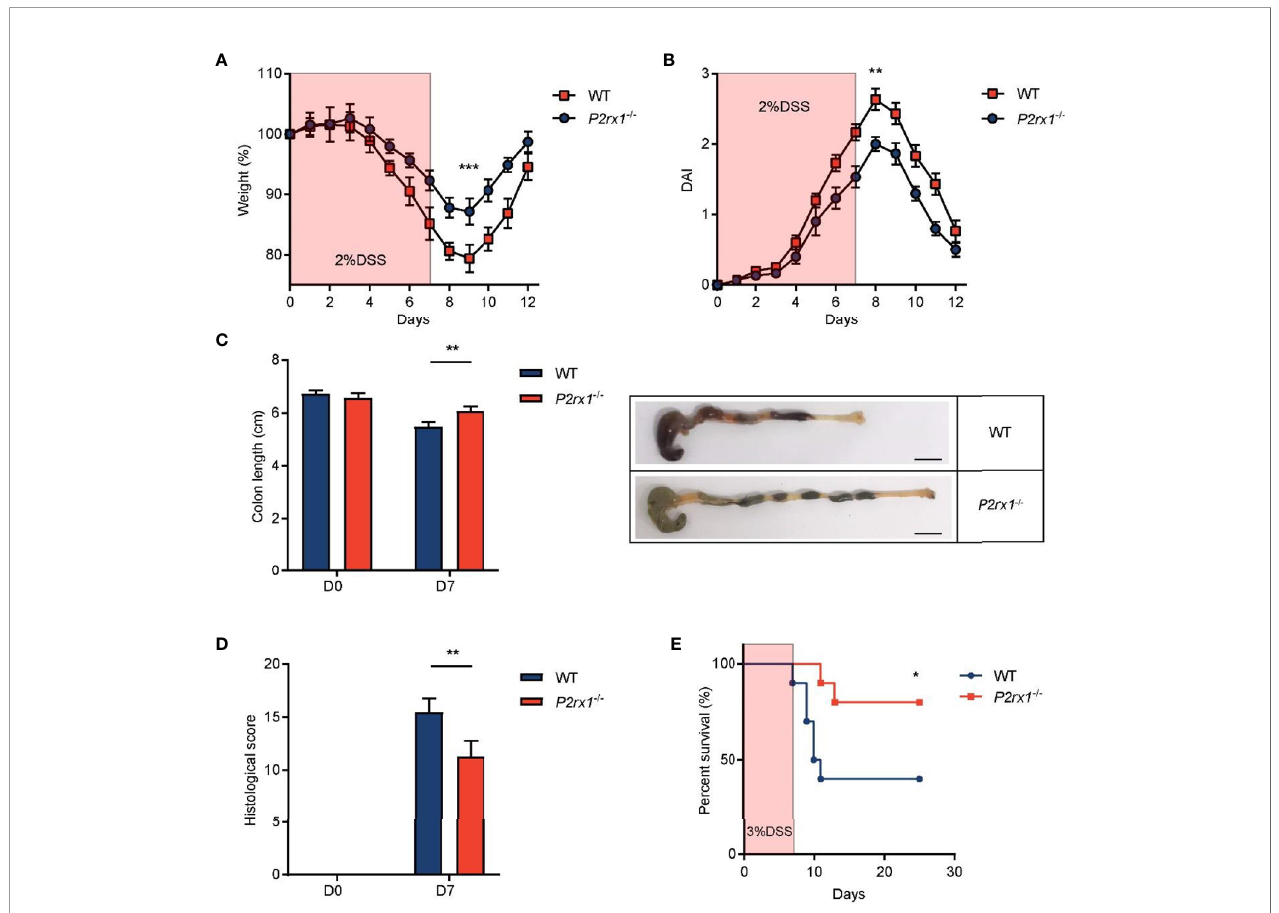
FIGURE 2 | P2RX1 ablation relieves DSS-induced mouse colitis. (A, B) WT and P2rx1 − / − mice were treated with 2% DSS for 7 days. Weight loss (A) and disease activity index (DAI) (B) were calculated (n = 6 per group). (C) Colon length of WT and P2rx1 − / − mice was measured at days 0 and 7. Representative colon tissues at day 7 were shown (n = 6 per group). Scale bar is 1 cm. (D) Histologic score of WT and P2rx1 − / − mice at days 0 and 7 was determined according to pathological examinations (n = 6 per group). (E) WT and P2rx1 − / − mice were exposed to 3% DSS for 7 days, and survival status was monitored for 25 days (n = 10 per group). *P < 0.05, **P < 0.01, and ***P <